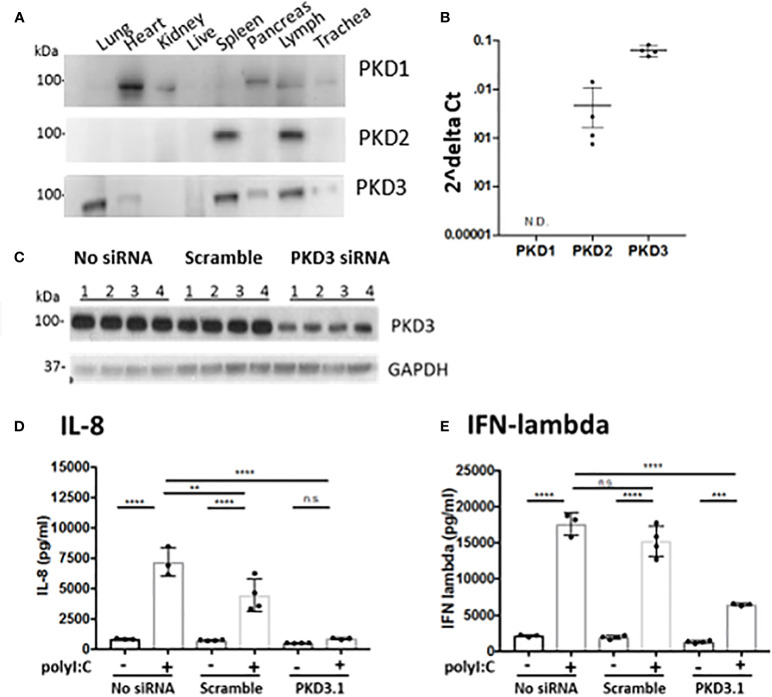
PKD3 is highly expressed in the lung and in 16HBE cells and promotes cytokine secretion. (A) Tissues from untreated C57BL/6 mice were analyzed for PKD isoforms via Western blot. (B) RNA was harvested from confluent16HBE monolayers and levels of the PKD isoforms were quantified with RT-PCR and normalized to GAPDH. (C) 16HBE cells were transfected with 20 pmol siRNA targeting PKD3 prior to 6hr stimulation with 5 μg/ml polyI:C. siRNA-mediated knock down of PKD3 in 16HBE cells was confirmed via Western blot, and supernatants were analyzed for IL-8 (D) and IFN-lambda (E)
via ELISA. Data are mean ± standard deviation. Each point represents an individually treated well from one experiment. One way ANOVA followed by unpaired Tukey’s multiple comparisons test. **p < 0.01, ***p < 0.001, ****p < 0.0001. ns=p>0.05.